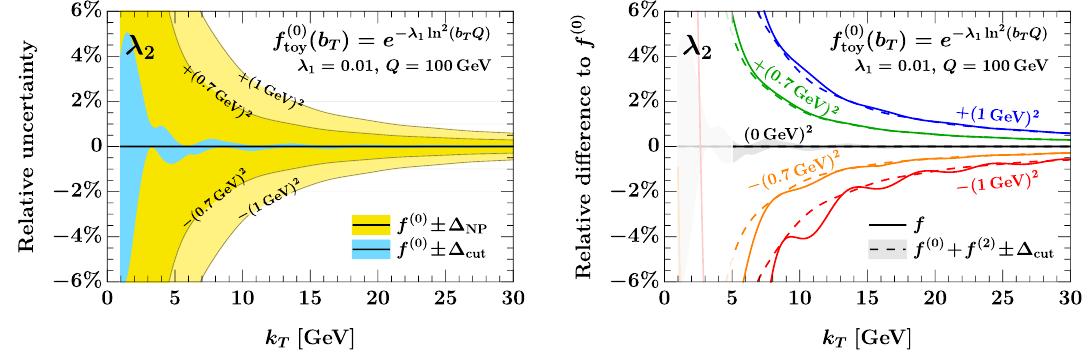
k = 10 GeV for λ = 1 GeV , which we attribute to the falloff of the spectrum beyond the 2 T Sudakov peak that is present also for this toy